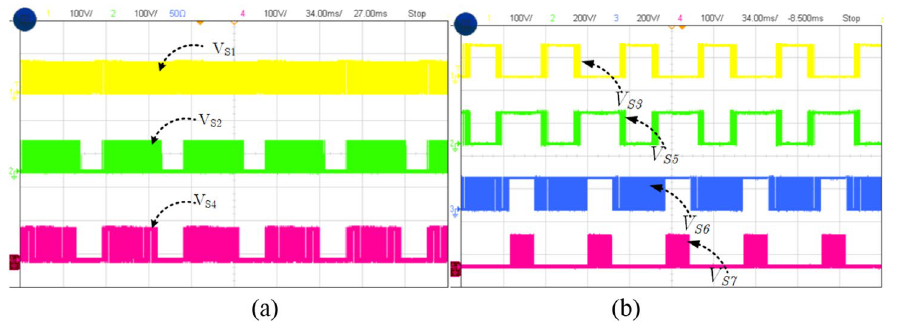
Figure 13. Voltage across the switches ( a ) V S1 , V S2 , V S4 and ( b ) V S1 , V S2 , V S4